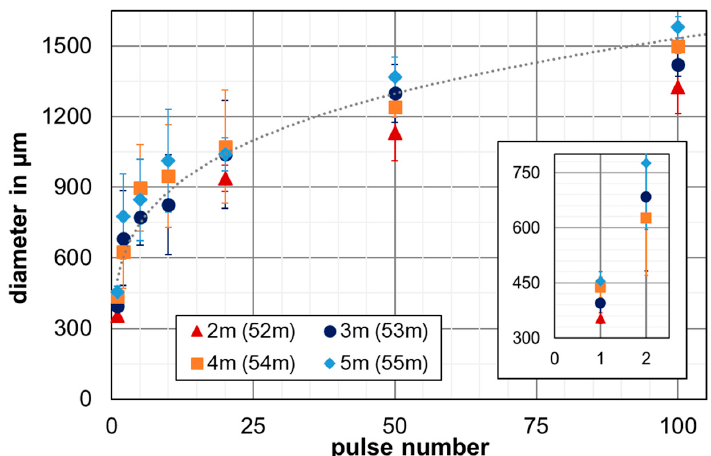
Figure 3. Increase in the filament-ablation-spot diameter as a function of pulse number and substrate position in the filament, which resulted from beam fluctuation in the propagating filament. The insert shows the ablation-spot diameters for 1- and 2-filament pulses in a magnified